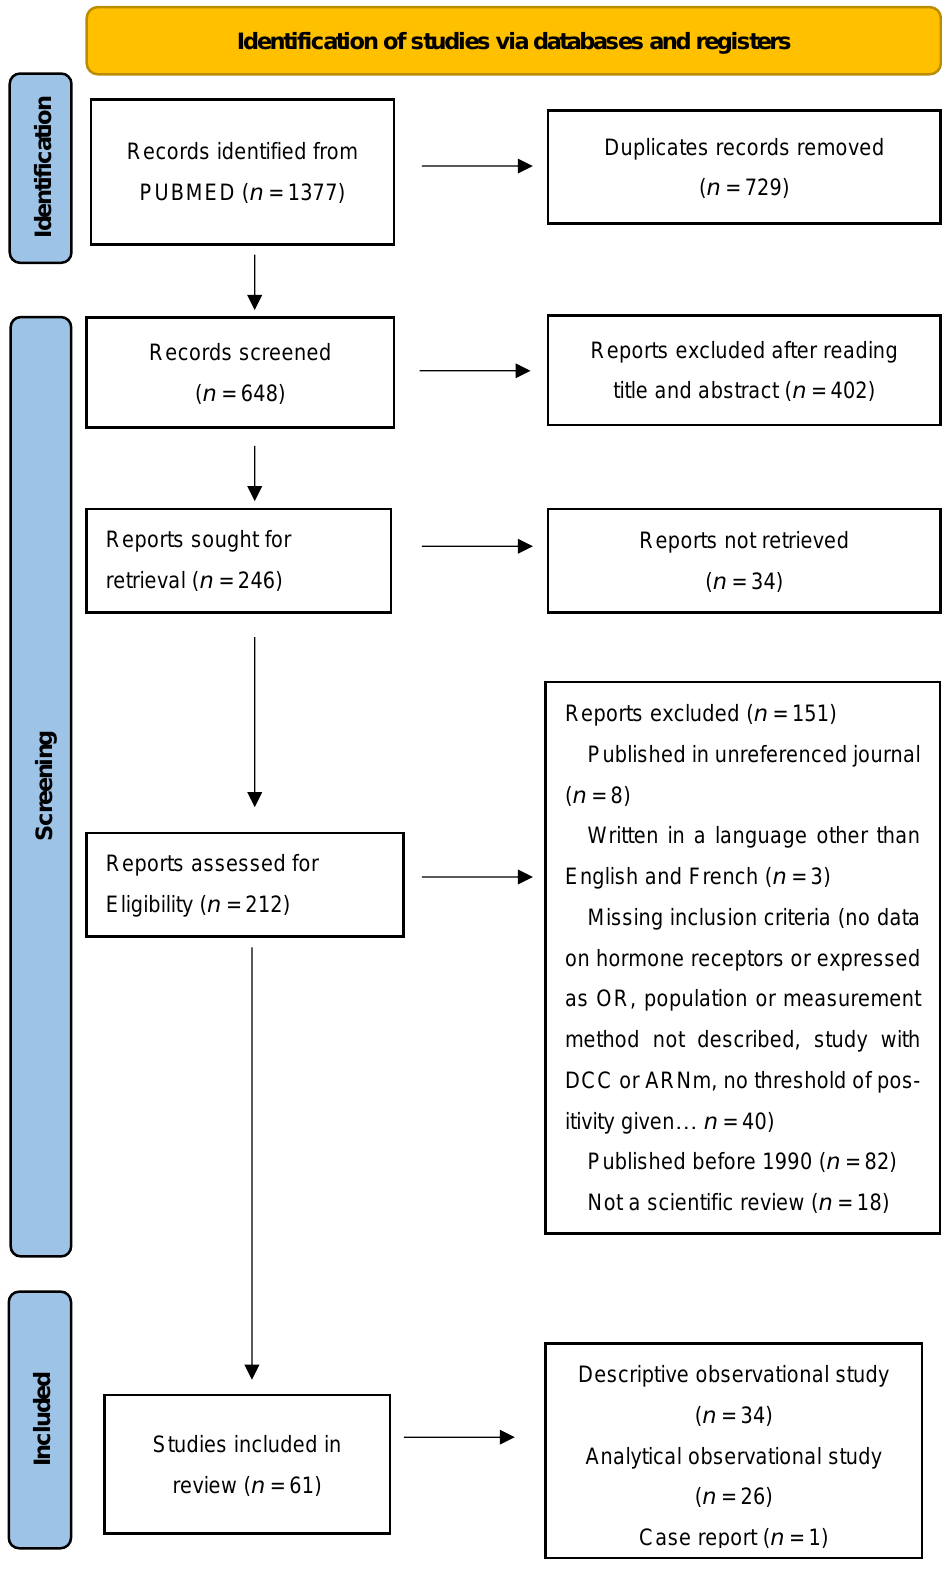
Figure A1. PRISMA flow diagram for studies included and excluded from the systematic review.